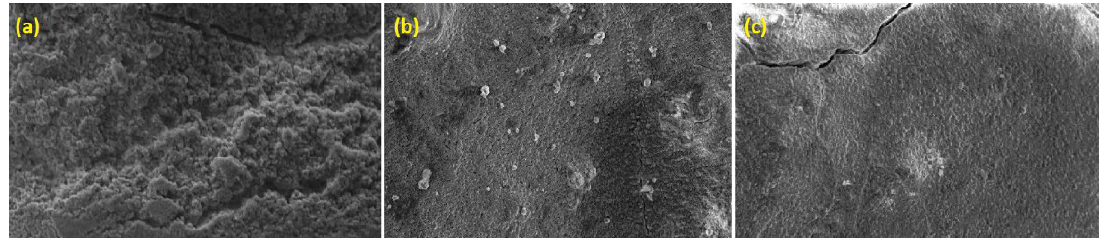
Figure 16 SEM images of the permeable concrete surface: (a) 3% TiO 2 ; (b) 6% TiO 2 ; 10% TiO 2